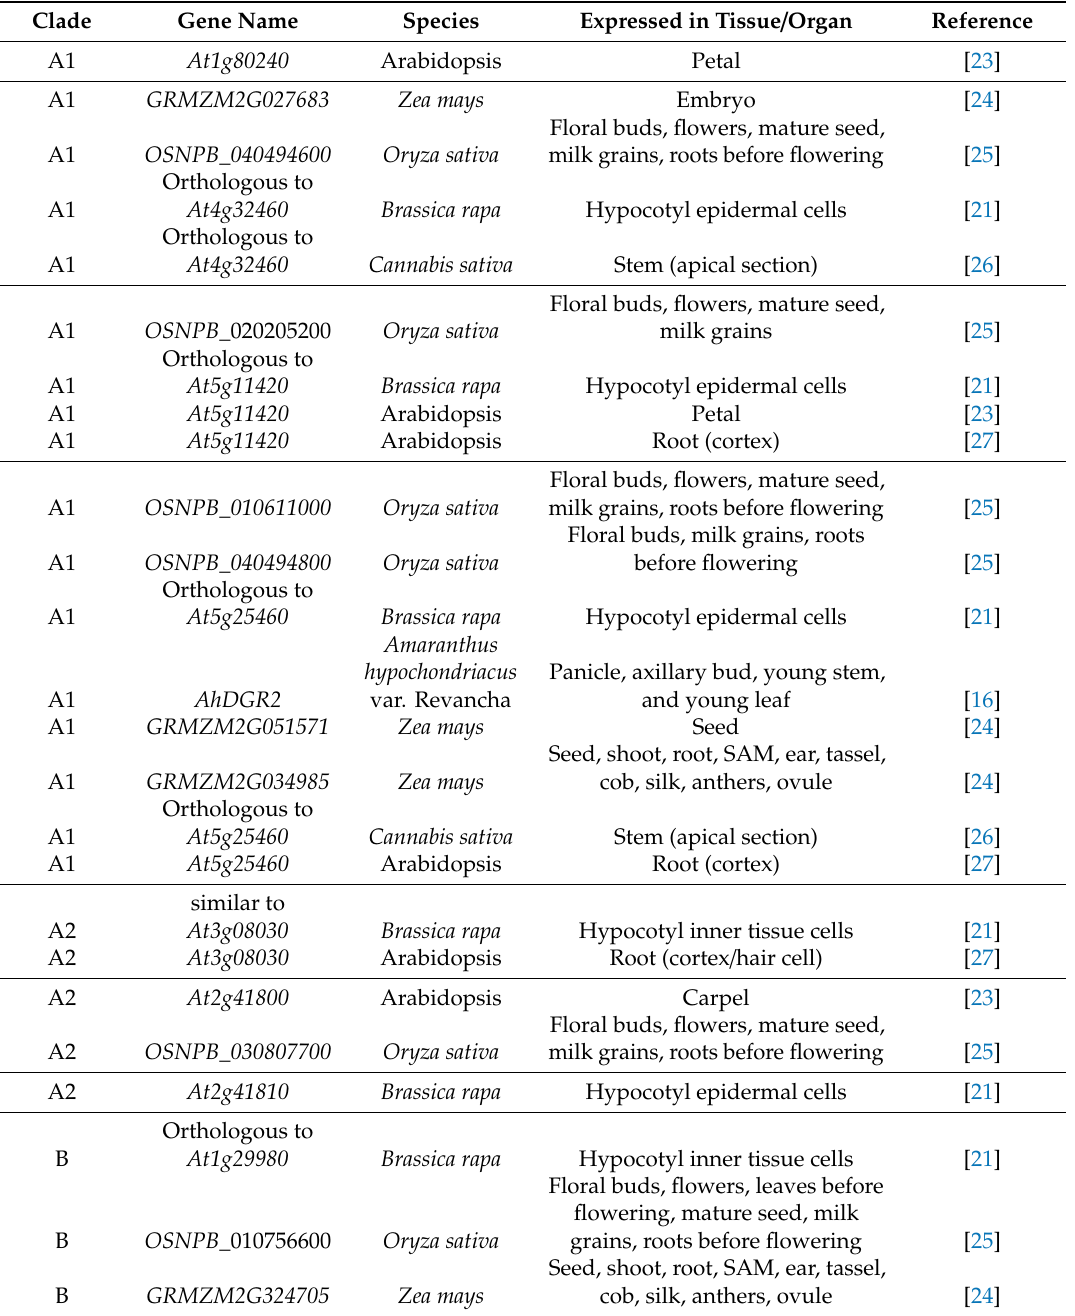
Table 1. Expression profiles of the DUF642 genes detected in distinct tissues / organs and species. DUF642 genes are grouped by clades as reported by V á zquez-Lobo et al. (2012) [9] and using the locus tag of Arabidopsis as a reference for gene